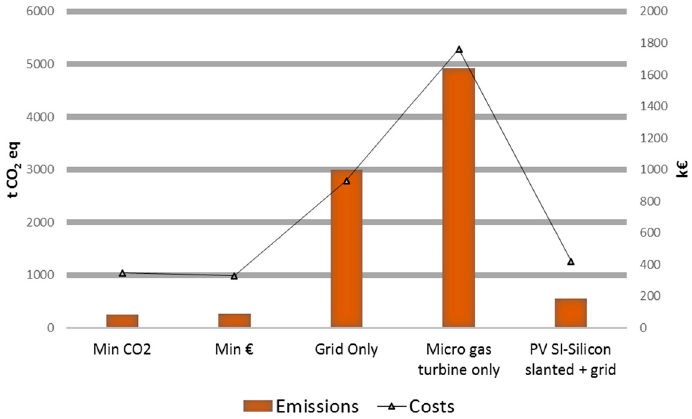
Figure 3. Comparison of different optimal and non ‐ optimal results.